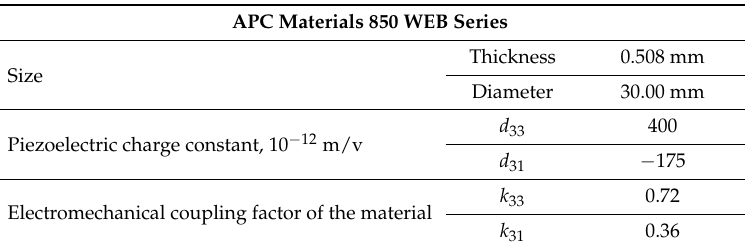
Table 1. Properties of the piezoelectric